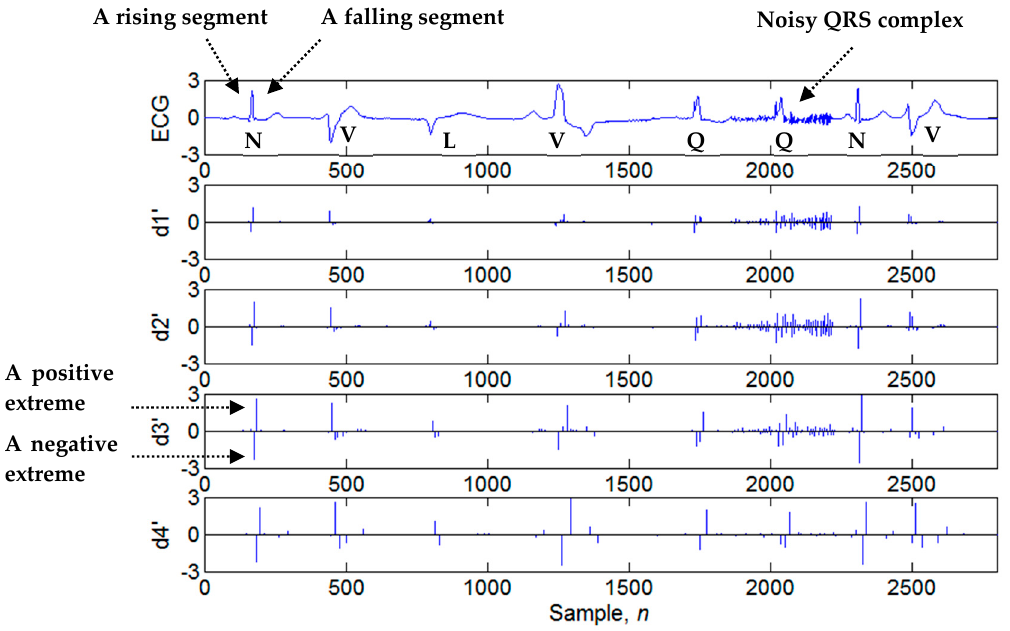
Figure 6. Illustrations of the extreme detail signals including only the extreme points of the detail signals, named d1’, d2’, d3’, and d4’ according to d1, d2, d3, and d4, respectively, in Figure 5.